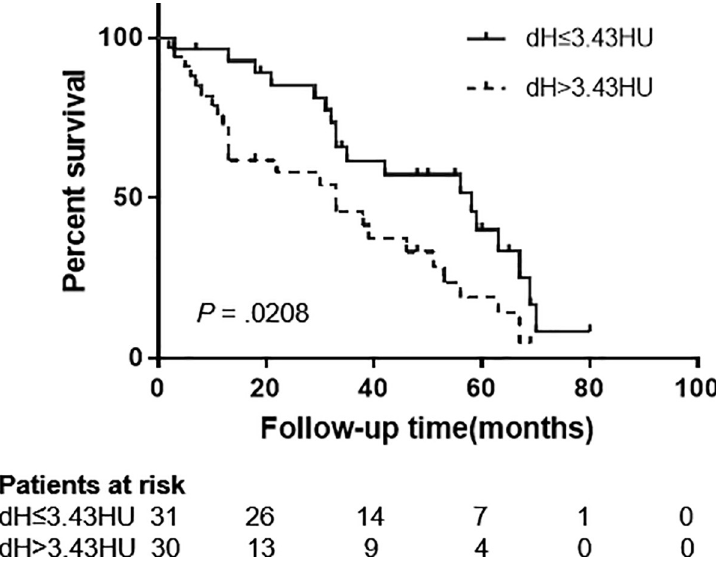
Fig 4. Correlation between MCTN and survival. Kaplan-Meier analysis of the patient percent survival as a function of the median MCTN change for patients studied during the follow-up period.